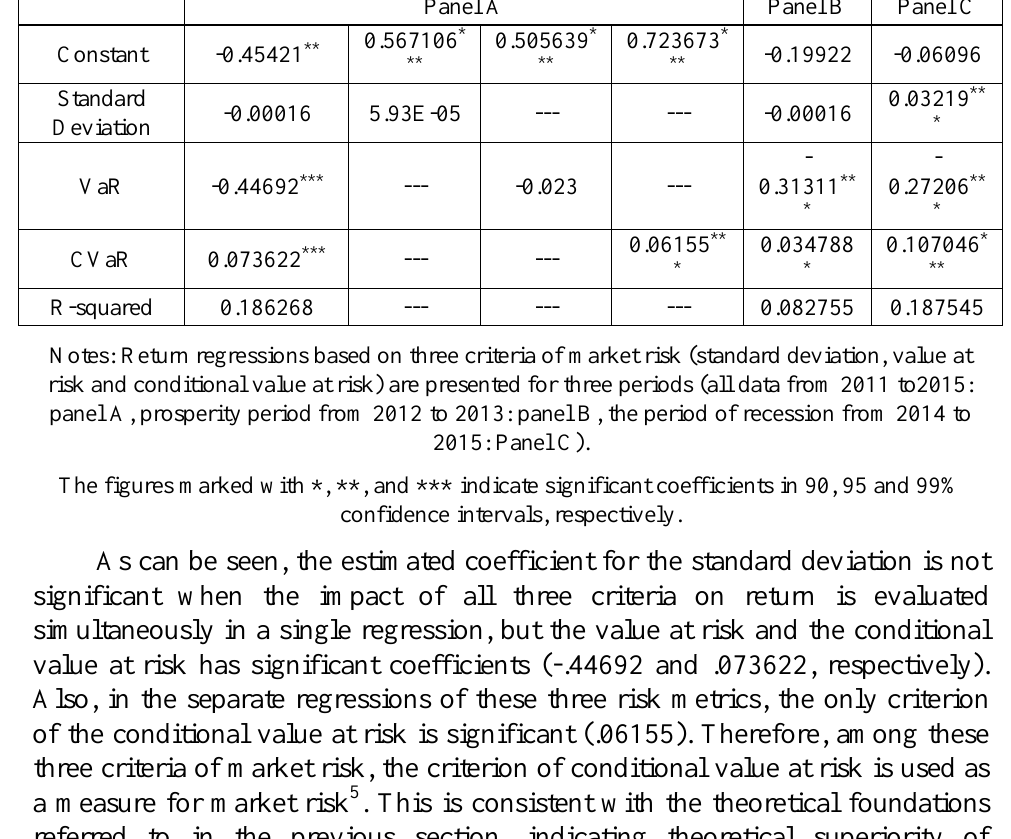
Table 1. Comparison of the effect of different market risk factors on return Panel